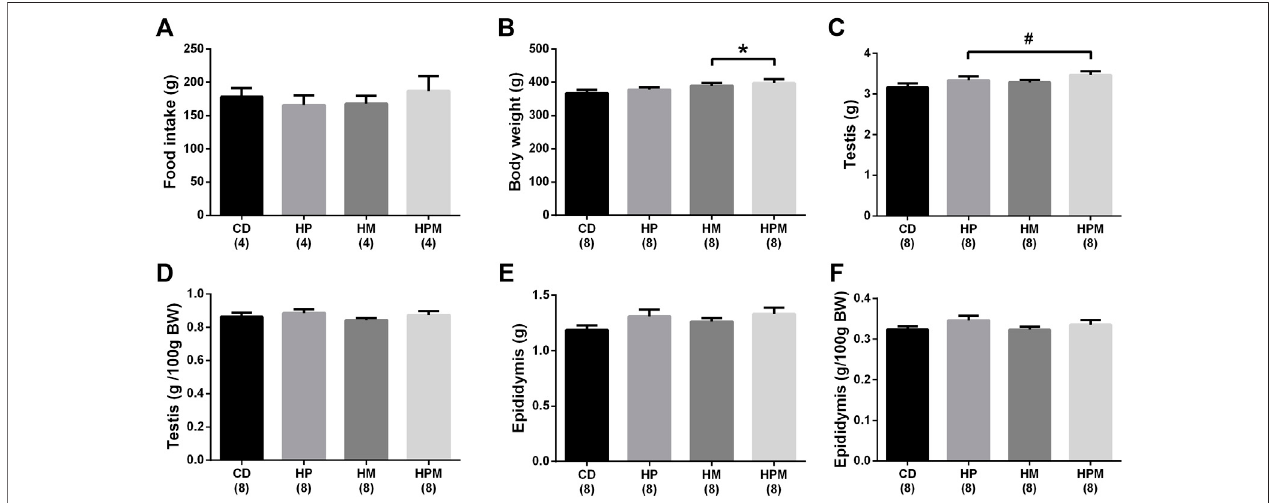
FIGURE 1 | Biometric data and food intake of male rat offspring from progenitors fed on high-fat high-sugar diet. Mean ± SEM; symbols indicate signi fi cant difference caused by parental diet ( p < 0.05): # statistically signi fi cant by the effect of paternal diet; *statistically signi fi cant by the effect of maternal diet. H: high-fat and high-sugardiet;CD(controlpaternalandmaternaldiet),HP(Hpaternaldietandcontrolmaternaldiet),HM(Hmaternaldietandcontrolpaternaldiet)andHPM(Hpaternal and maternal diet); BW: body weight. (A) : food intake; (B) : body weight (g); (C) : testis (g); (D) : testis (g/100 g BW); (E) : epididymis (g); epididymis (g/100 g BW); ( n = 8).